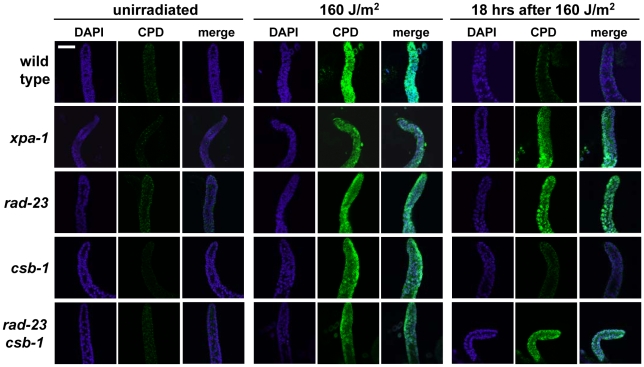
CPD repair in C. elegans germ cells.Immunofluorescence on dissected gonads shows that after 160 J/m2 UVB irradiation, CPD damage (green) is repaired in wild type and csb-1 animals, but not in xpa-1, rad-23 and rad-23; csb-1 animals. Repair was visualized 18 hours after irradiation, as at this time point the majority of CPDs in C. elegans are repaired [52], [65], while the proliferation arrest caused by UV irradiation in distal mitotic germ cells still lasts [22]. To visualize germ cell nuclei, DAPI staining (blue) was used. Bar in first image represents 20 µm.